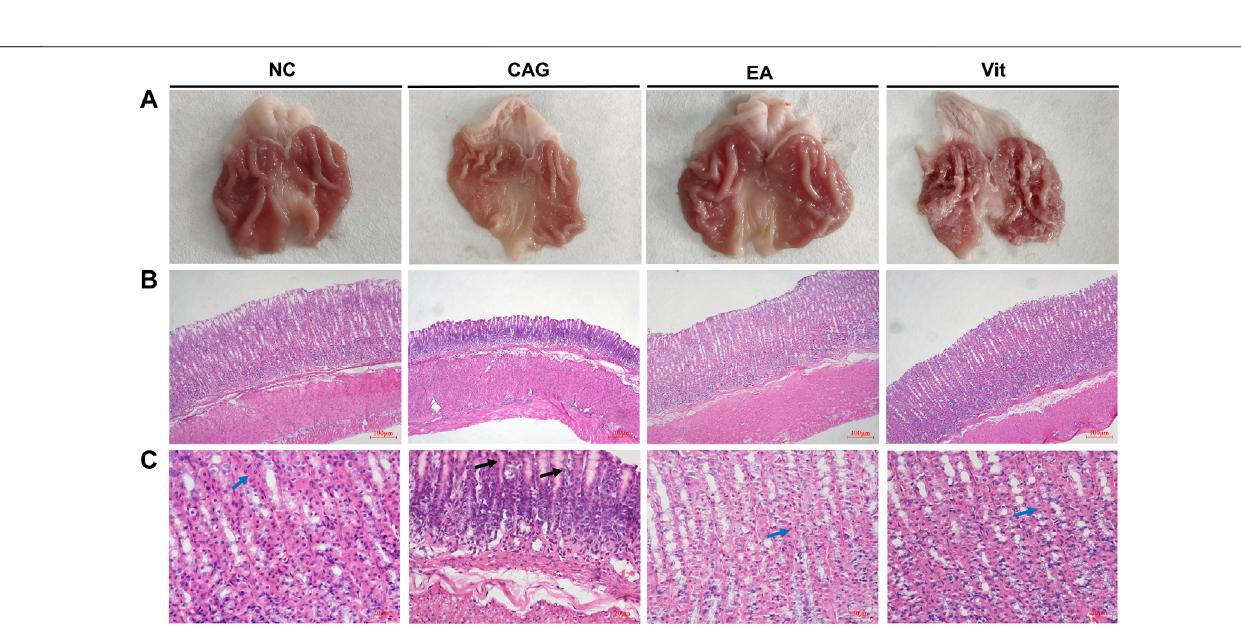
Frontiers in Genetics |